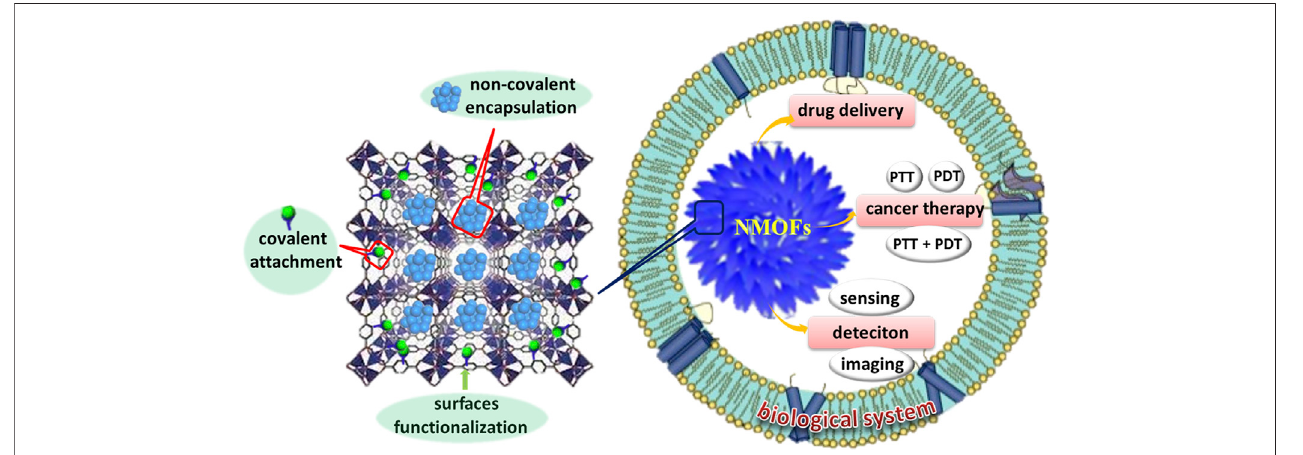
FIGURE 1 | Schematic diagrams of NMOFs in